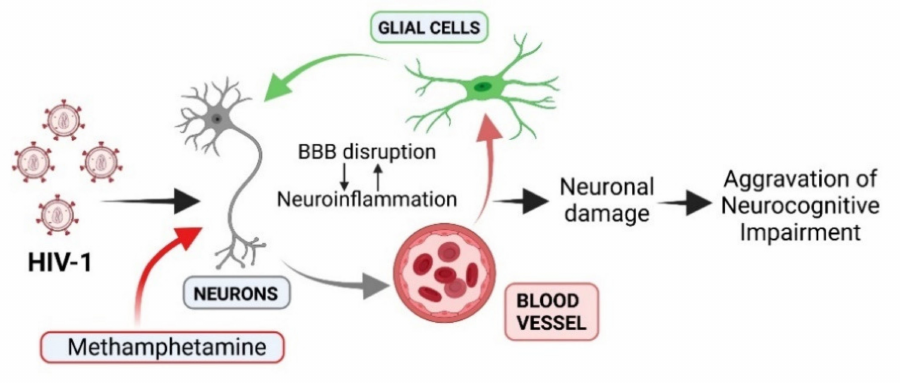
Figure 1. A schematic diagram illustrating a possible contribution of neurovascular unit (NVU) dis- ruption to increased neurocognitive impairment in comorbid HIV-1 infection and methamphetamine (METH) use. The NVU is composed of vascular cells, glial cells, and neurons. METH use and HIV-1 infection compromise blood–brain barrier (BBB) integrity facilitating transmigration of in- fected immune cells and viral entry across the BBB. This can potentially lead to neuroinflammatory responses by microglia that can further promote BBB disruption. These events result in worsening neuronal damage and aggravating neurocognitive impairments involved in the pathogenesis of HIV-1-associated neurocognitive disorders (HAND). Created with